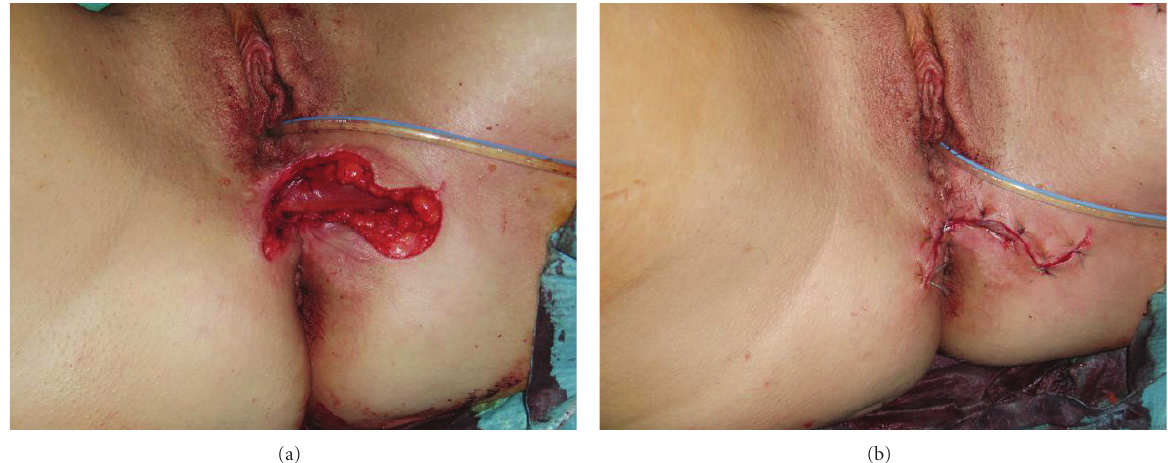
Figure 3: The gracilis muscle flap was interpositioned between the pouch and vagina.